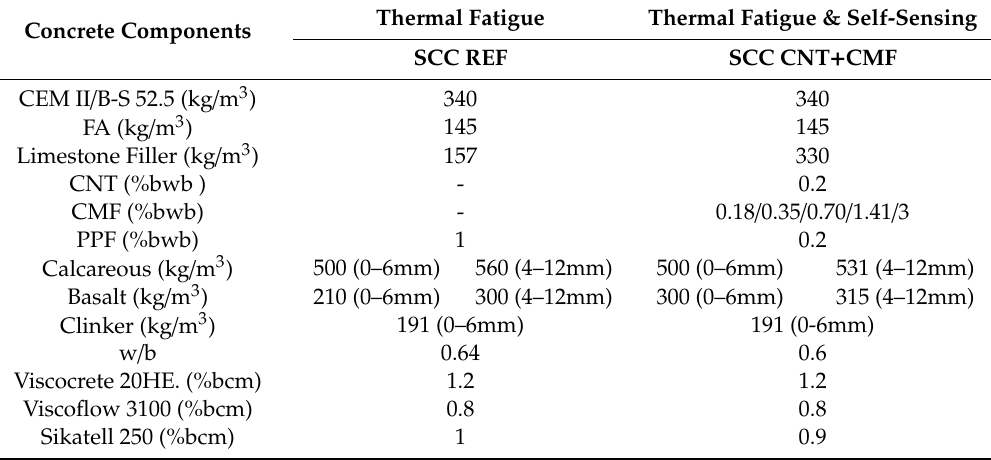
Table 4. Dosages of self-compacted concretes (SCCs) with low thermal expansion aggregates.